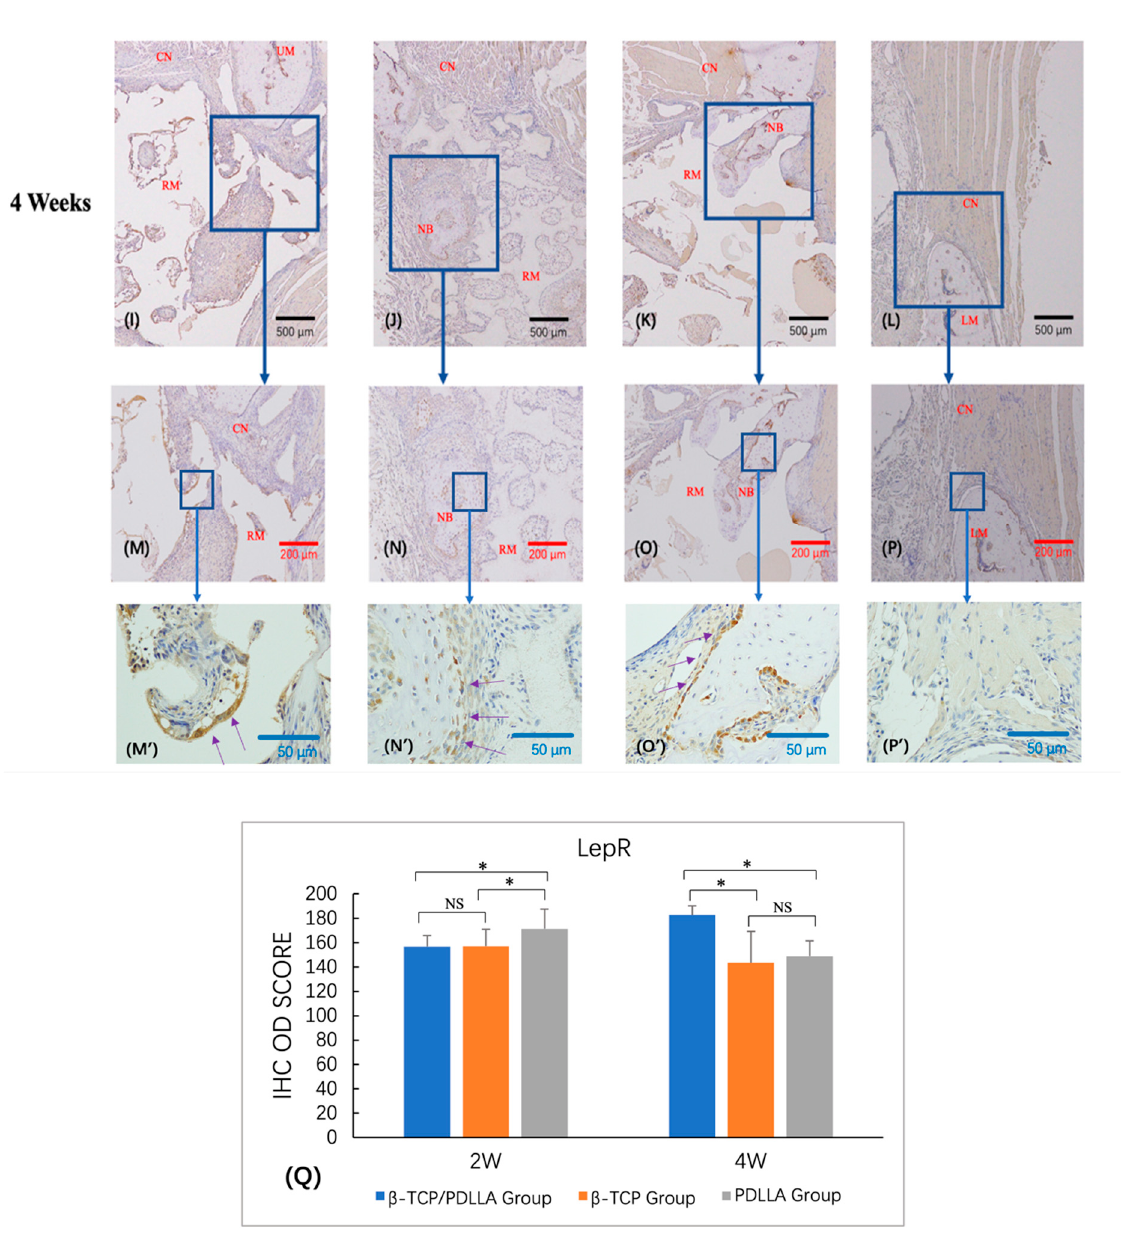
Figure 8. Immunohistochemical staining of LepR in the β -TCP/PDLLA ( n = 3), β -TCP ( n = 3), PDLLA ( n = 3), and sham ( n = 3) groups. ( A – H , E’ – H’ ) Sections at 2 weeks after mandibular defect surgery. ( I – P , M’ – P’ ) Sections at 4 weeks after mandibular defect surgery. UM, upper mandible; LM, lower mandible; RM, residual material; NB, newly formed bone; CN, connective tissue; OD, optical density. All slices are shown at ×4, ×10 and ×40 magnification. Scale bars: 500 μ m (black), 200 μ m (red), and 50 μ m (blue). The purple arrows indicate the monolayer positive for LepR expression in each group. ( Q ) The OD of LepR was analyzed using the Kruskal–Wallis test and the pairwise comparisons were used as the post hoc test; * p < 0.05; NS, not significant. Error bars indicate standard deviation.